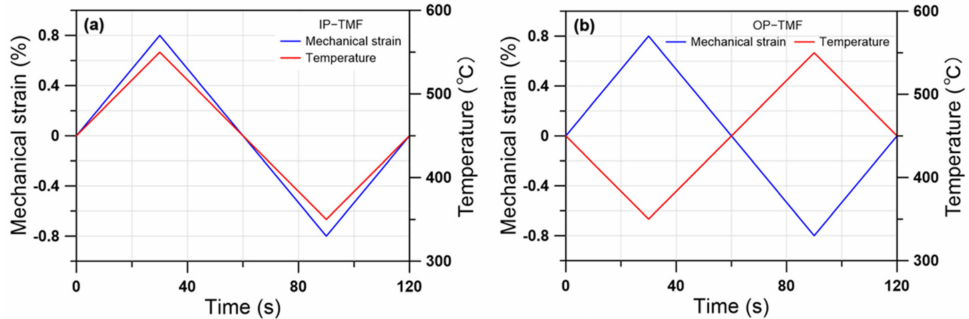
Figure 2. Schematic illustration of TMF tests under conditions of ( a ) IP and ( b ) OP,